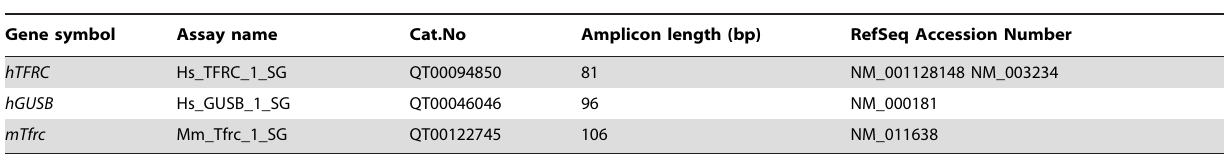
Table 2. Qiagen Quantitect primer assays.